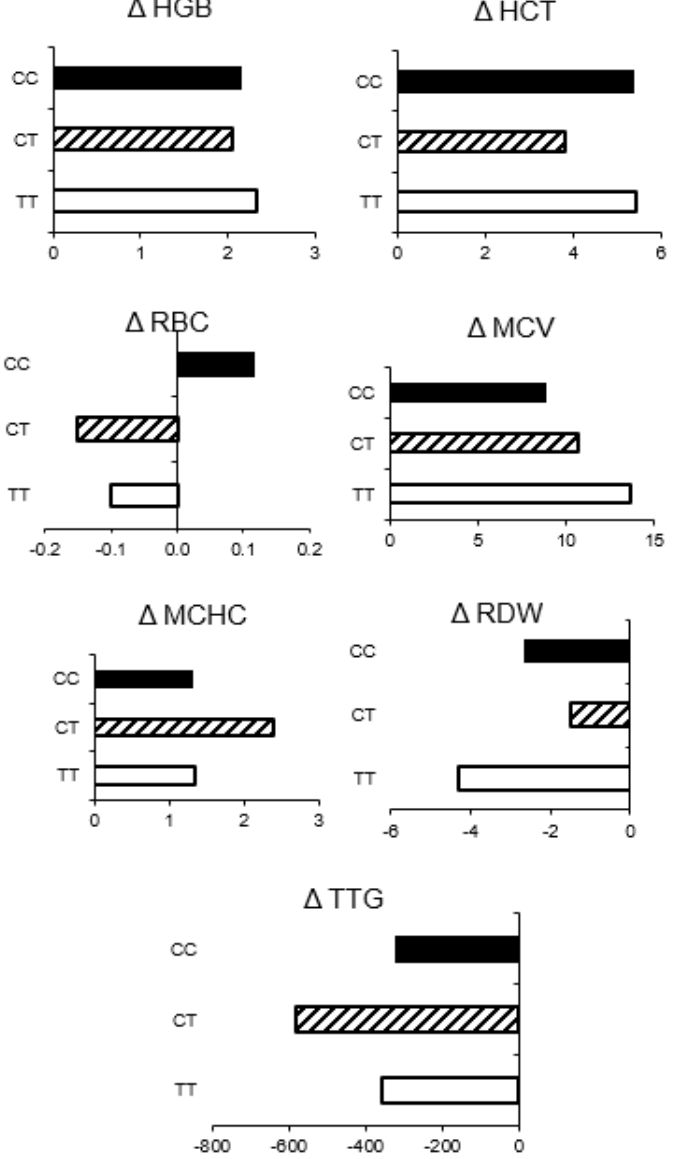
Figure 4. Changes in morphometric parameters and TTG levels between values at diagnosis and after 12 months of GFD in children with CD and initial anemia ( n = 25), according to the genotype. The results are expressed as the mean of delta values.